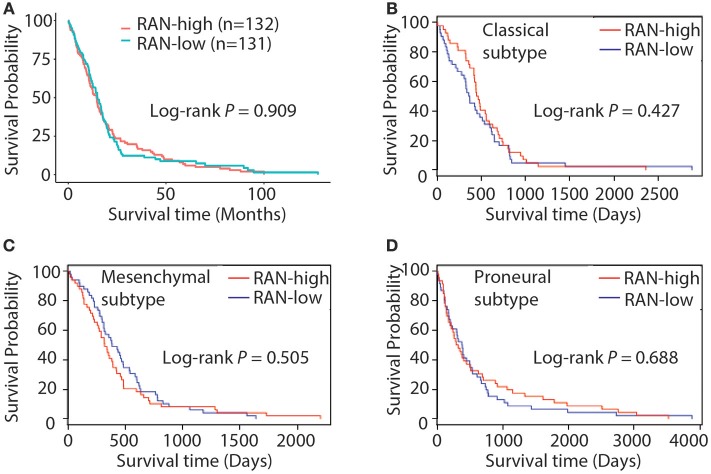
Kaplan-Meier analysis of RAN expression and GBM patient survival. (A) Survival curve of GBM patients with different levels of RAN. Results were retrieved from the GlioVis database. Survival curves of classical (B), mesenchymal (C), and proneural (D) GBM patients with different levels of RAN were retrieved from the Glioblastoma Bio Discovery Portal. Log-rank P-values are shown.